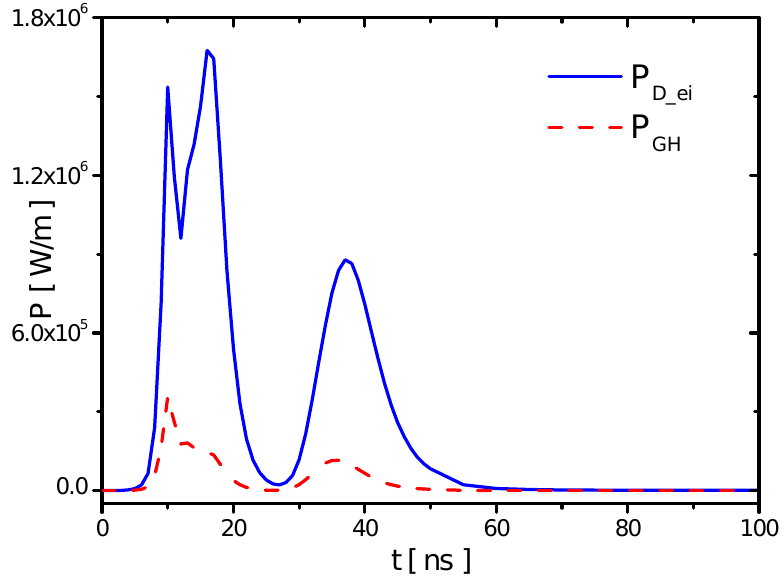
Figure 18. The powers of discharge energy P D _ ei and the fast gas heating P GH in Case